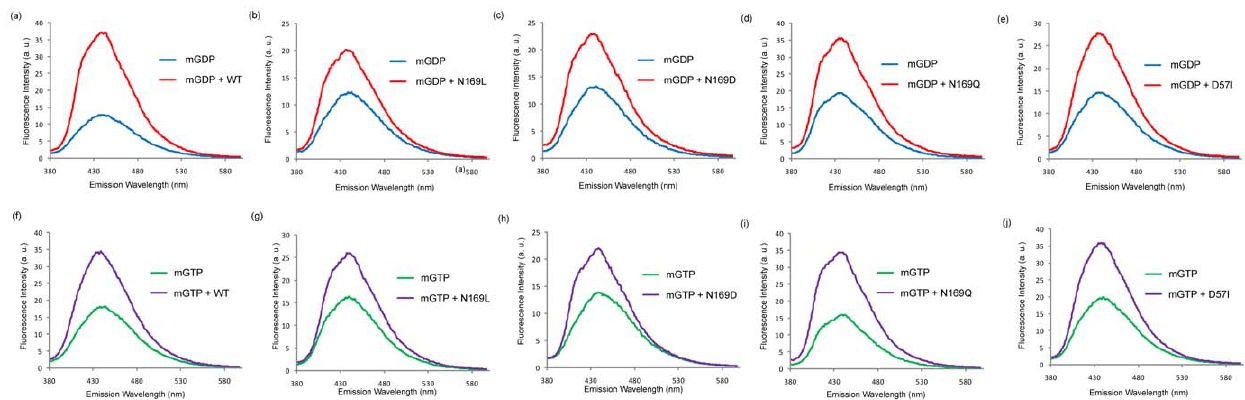
Figure 5. Nucleotide binding by YqeH Mutants. The ability of YqeH Mutants to bind nucleotides GTP and GDP is examined by measuring fluorescence intensity (in arbitrary units) of mant-GTP and mant-GDP ( l ex - 355 nm, l em - 440 nm). The intrinsic and protein induced fluorescence of mGDP (blue and red curves, respectively) and mGTP (green and purple curves, respectively) is shown for (a & f) wild type, (b & g) N169L, (c & h) N169D, (d & i) N169Q and (e & j) D57I. Appreciable increase in fluorescence is observed for all mutants suggesting that they bind nucleotides.